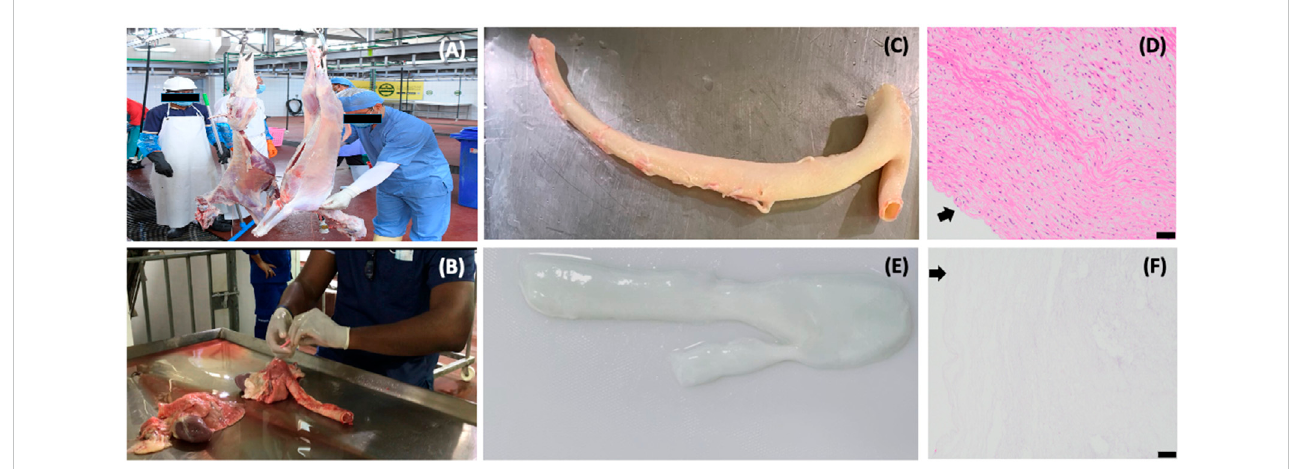
FIGURE 2 Decellularized vascular scaffolds created from biological waste obtained using native sheep aorta collected at a local slaughterhouse. These images provide an example of the repurposing process, whereby harvested organs are transformed into viable scaffolds for tissue-engineering purposes: (A) processing of sheep at the local slaughterhouse for the collection of meat, (B) discarded thoracic sections being dissected to obtain the aorta, (C) an intact aorta that was dissected and prepared for decellularization directly after it was harvested, (D) histologic image of a native aorta shown in image (C) , (E) aorta after decellularization, and (F) histologic image of the decellularized aorta showing the signi fi cant variation in cellular components present in the native structure compared to the scaffold (E) . Arrows in images (D) and (F) identify tunica intima and vascular lumen, and scale bars represent 50